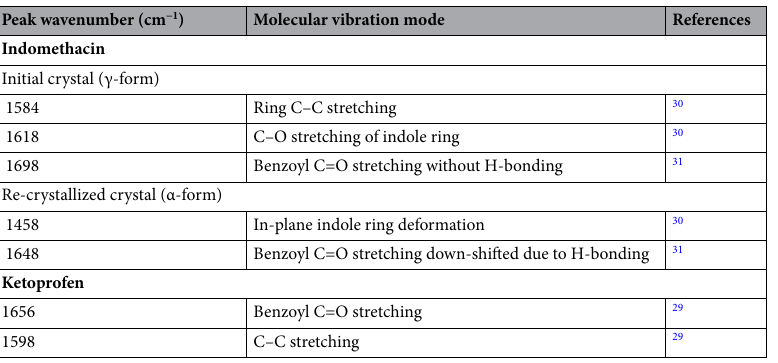
Table 1. Assignment of Raman peaks of indomethacin and